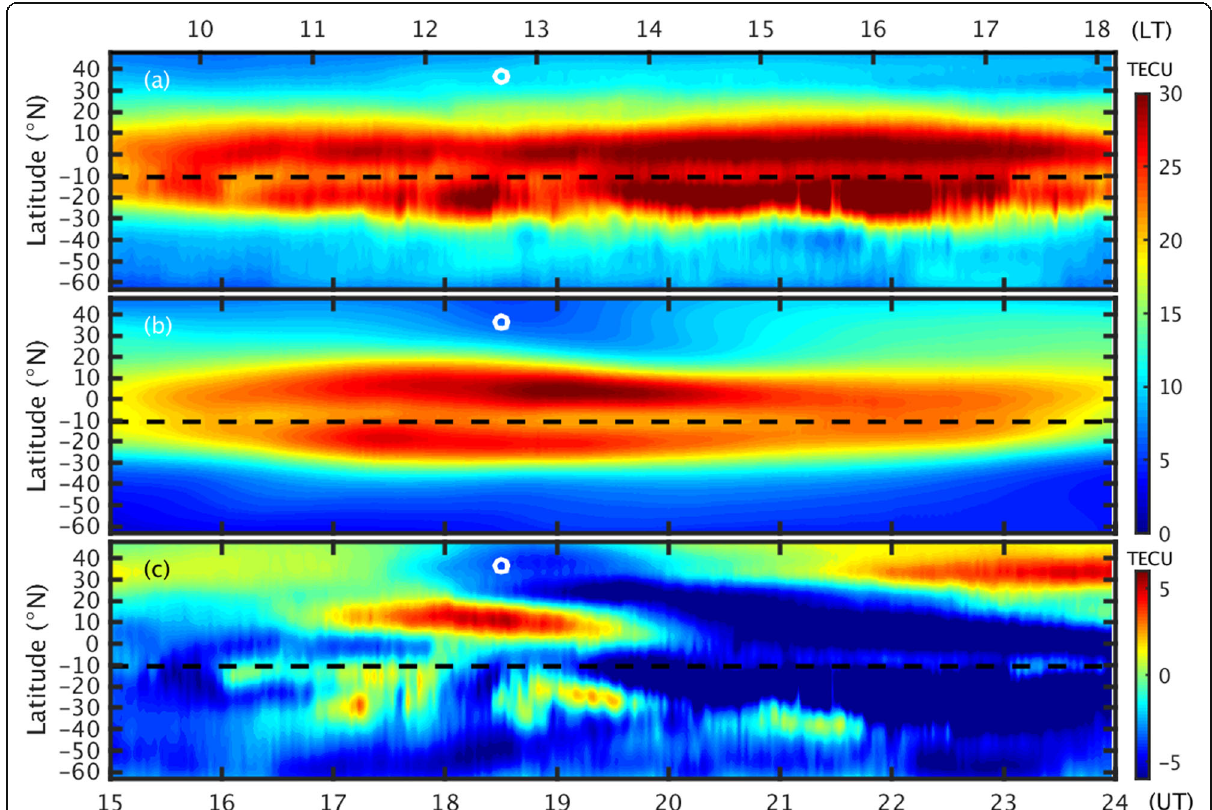
Fig. 3 The latitude-time variations of TEC along the magnetic field line (shown in the bottom panel of Fig. 1d) from the assimilation results on the eclipse previous day ( a ) and the eclipse day ( b ), and the difference ( c ) between the TEC of a and b . The white circle indicates the latitude and the time of the maximum obscuration of the solar